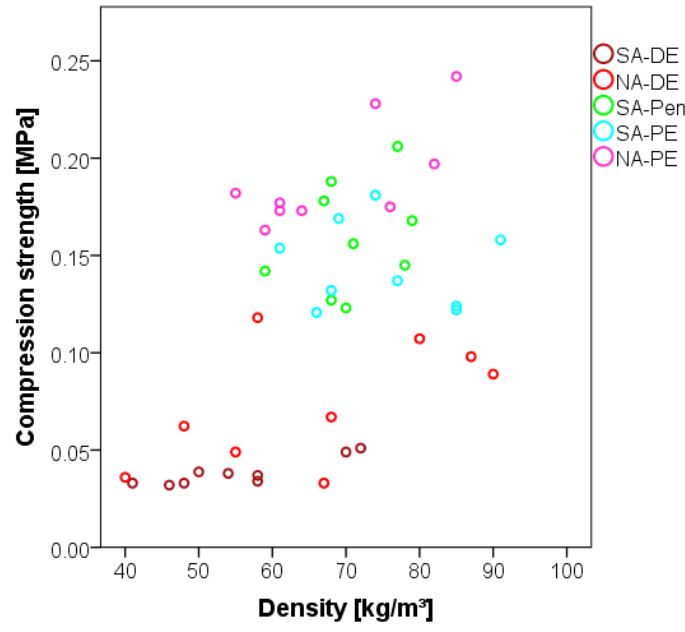
Figure 4. Compression strength of the foams against density .